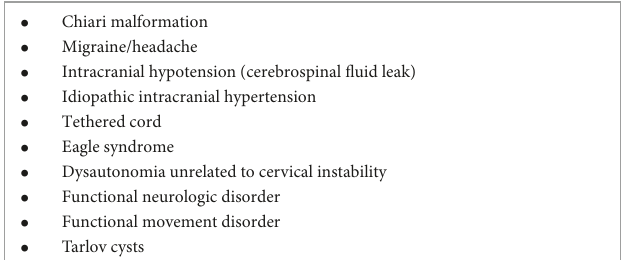
TABLE 9 Physical tests and findings only for low Irritability patients. Ligamentous